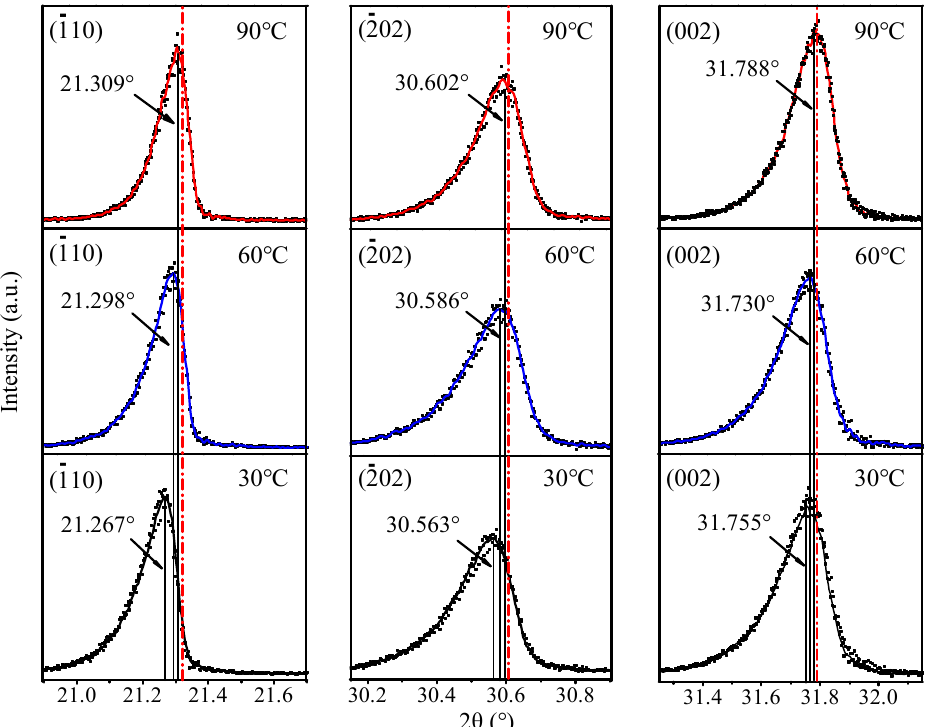
Figure 6. XRD spectra of (110), (202 ) and (002) planes of Li 2 CO 3 samples after recrystallization in Na 2 CO 3 solution.